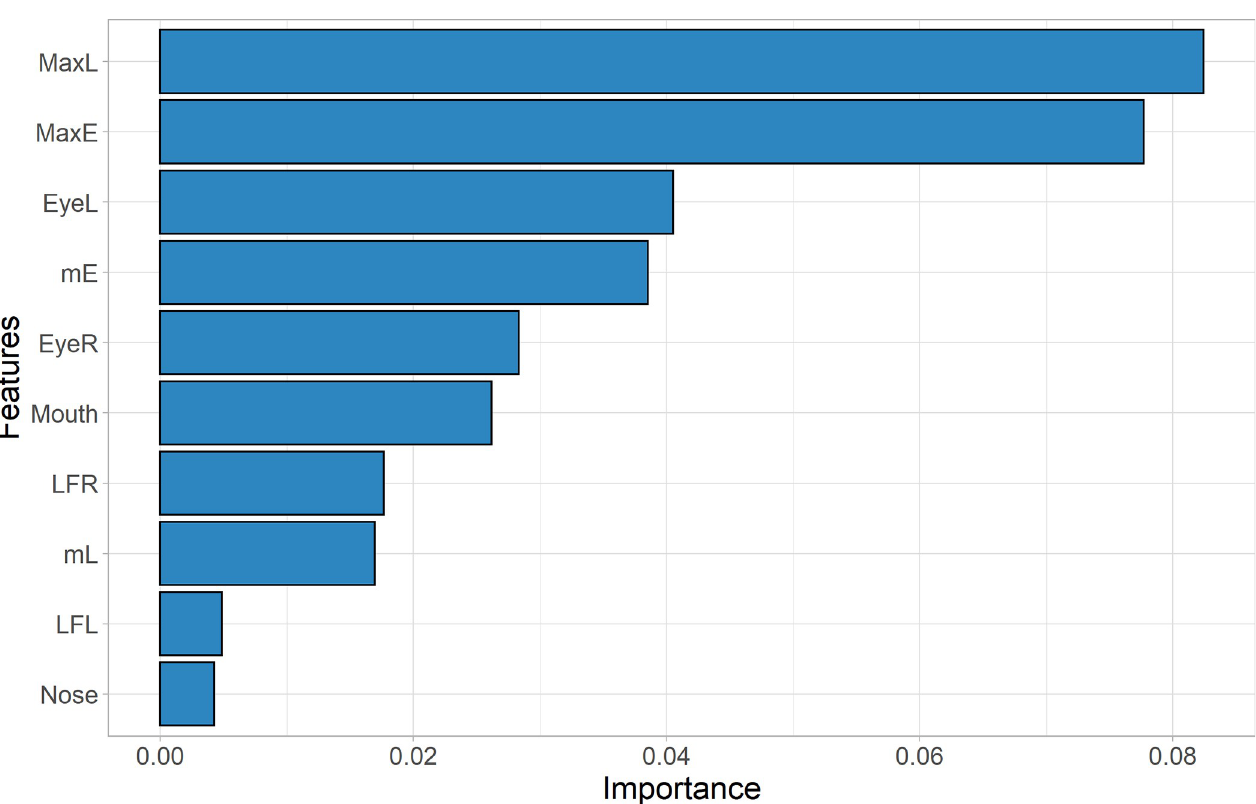
Fig 6. Feature importance analysis based on permutation technique (extracted from the Random Forest Model). The most important features responsible for model classification were MaxL and MaxE.